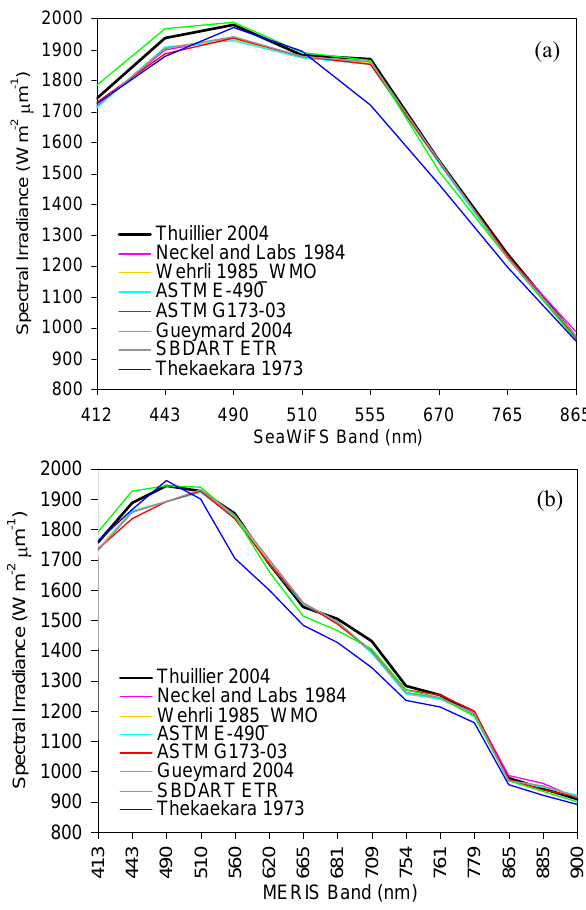
Fig. 3a. The spectral irradiance of the eight reference spectra in the UV to NIR (from 350-1200nm) domains, (b-d) their magnified portions in the ultraviolet-blue-green and NIR, and (e) the peak- normalized irradiance values (at 451nm) in the 350-1200nm range.